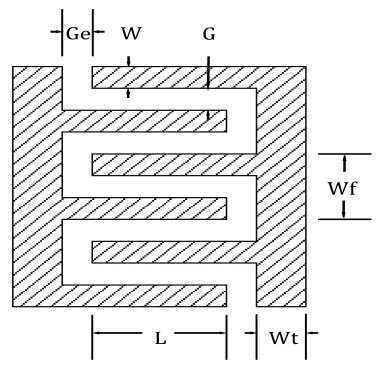
Figure 4. Geometry layout of the microstrip interdigital